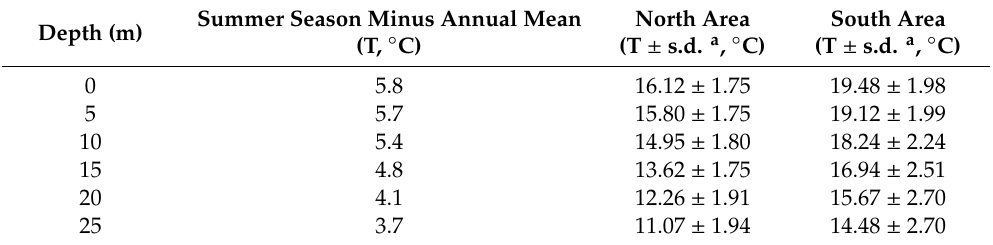
Table 4. Summary of temperature summer conditions (mean ± s.d.) in New England area based on the period of 2005 to 2012. Depth